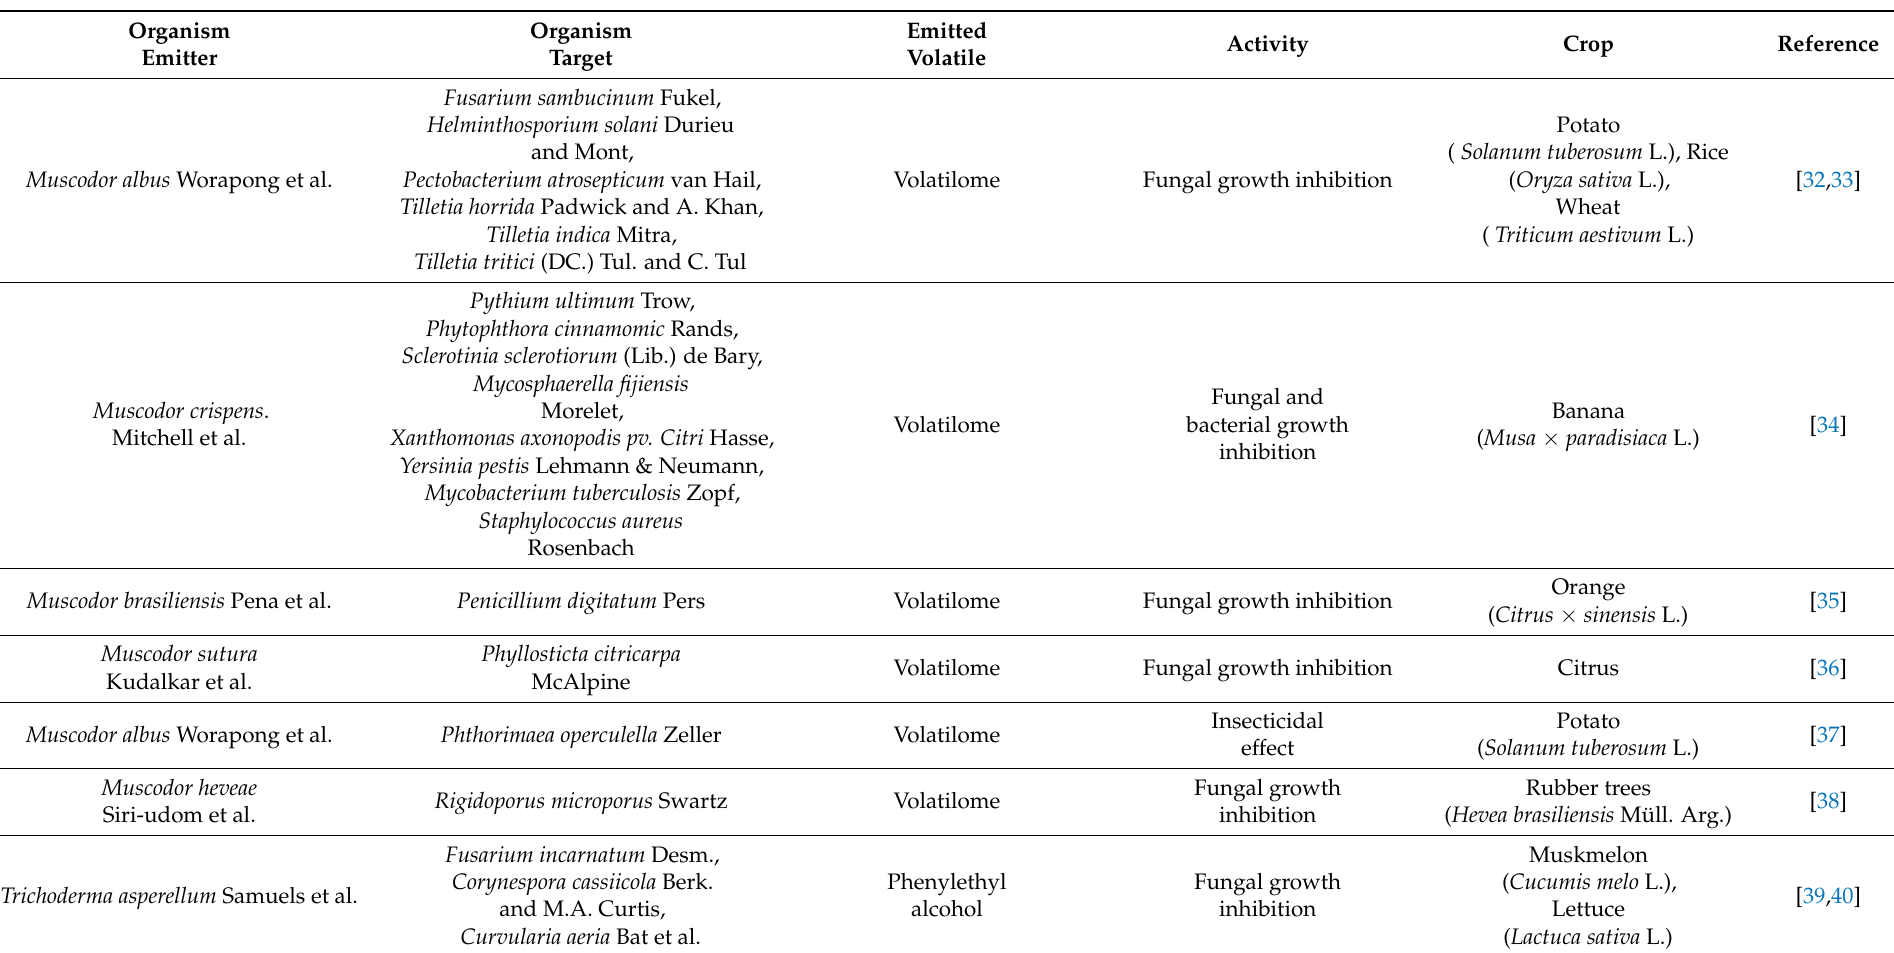
Table 1. Microbial volatile organic compounds with application in postharvest diseases